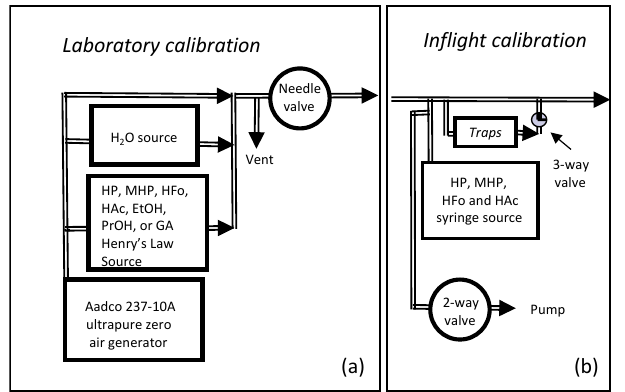
Figure A2. Block schematic of laboratory (a) and in-flight calibra- tion systems (b) , mass flow controllers are not shown. After Tread- away et al.